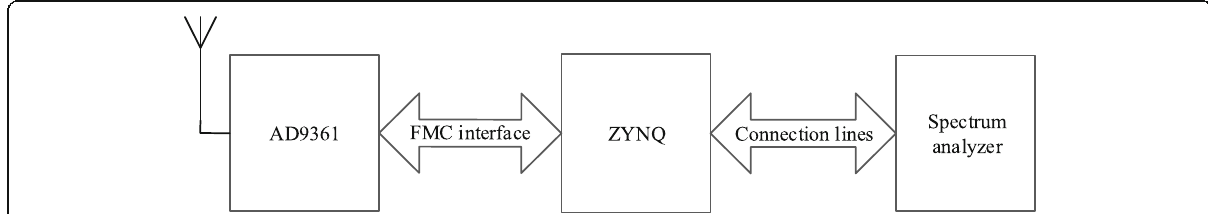
Fig. 16 The test framework of the receiving terminal. The test framework of the receiving terminal. Joint testing is performed for the designed software radio receiver, which is based on the hardware platform of AD9361